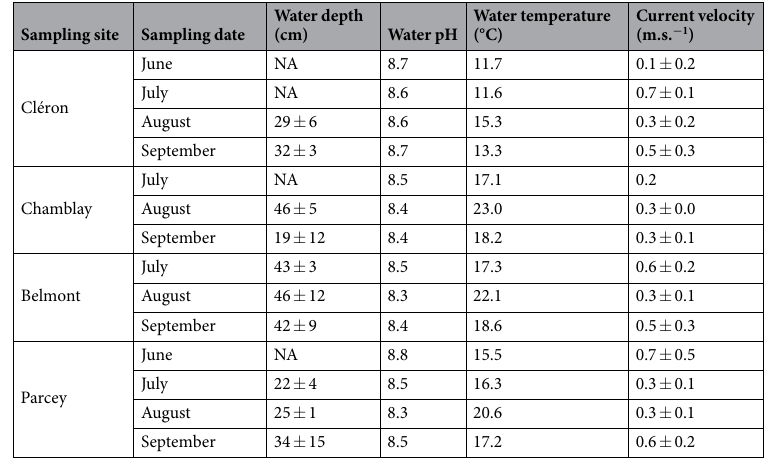
Table 1. Environmental and physico-chemical data measured at each sampling site and date. Values ( ± s.d.) corresponded to means of three replicate environmental measurements.